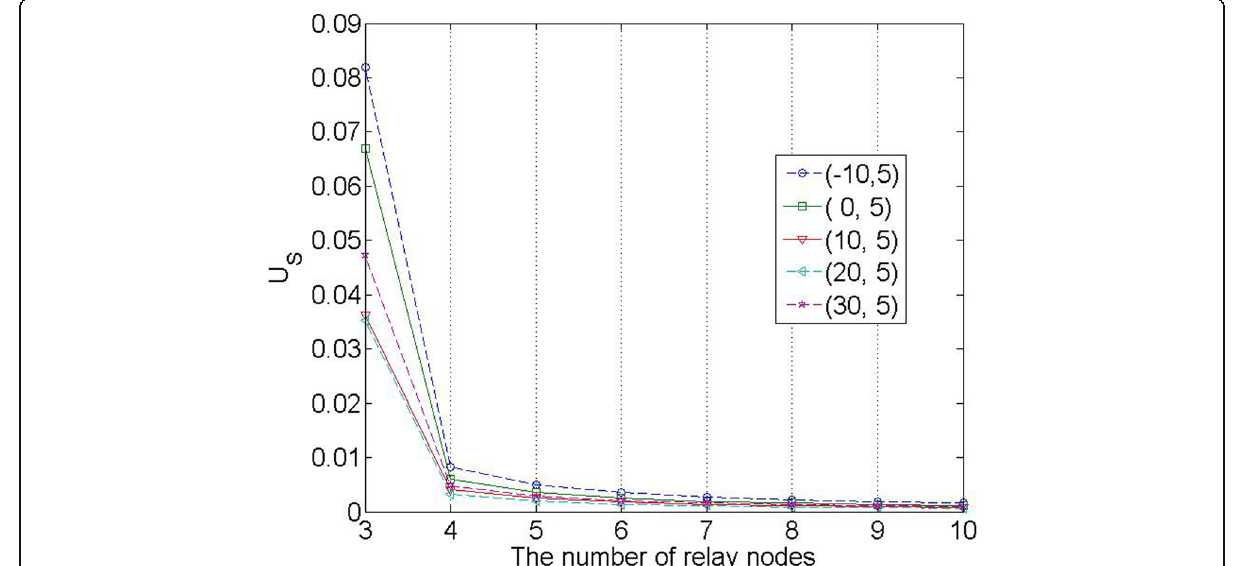
Fig. 8 The total payment U S of the source node Vs the number of cooperative relay nodes